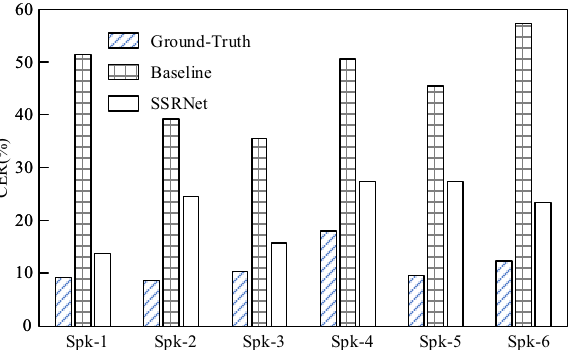
Figure 8. Objective accuracy comparison between the ground-truth voices, reconstructed voices from the baseline, and